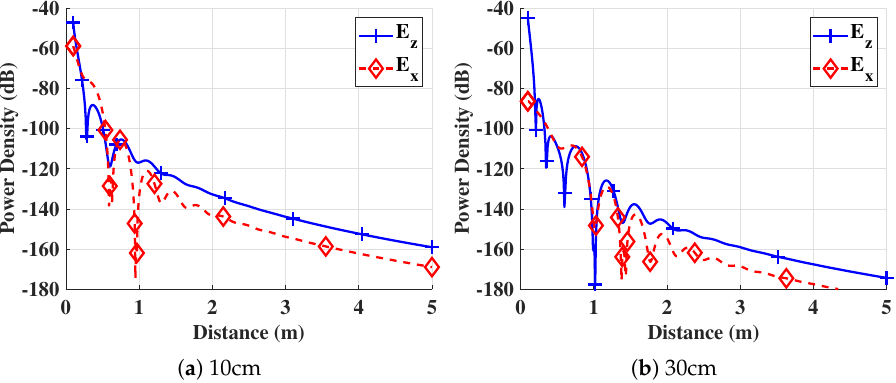
Figure 4. The comparison of the power density of E x and E z components at different burial depths: ( a ) 10-cm depth; ( b ) 30-cm